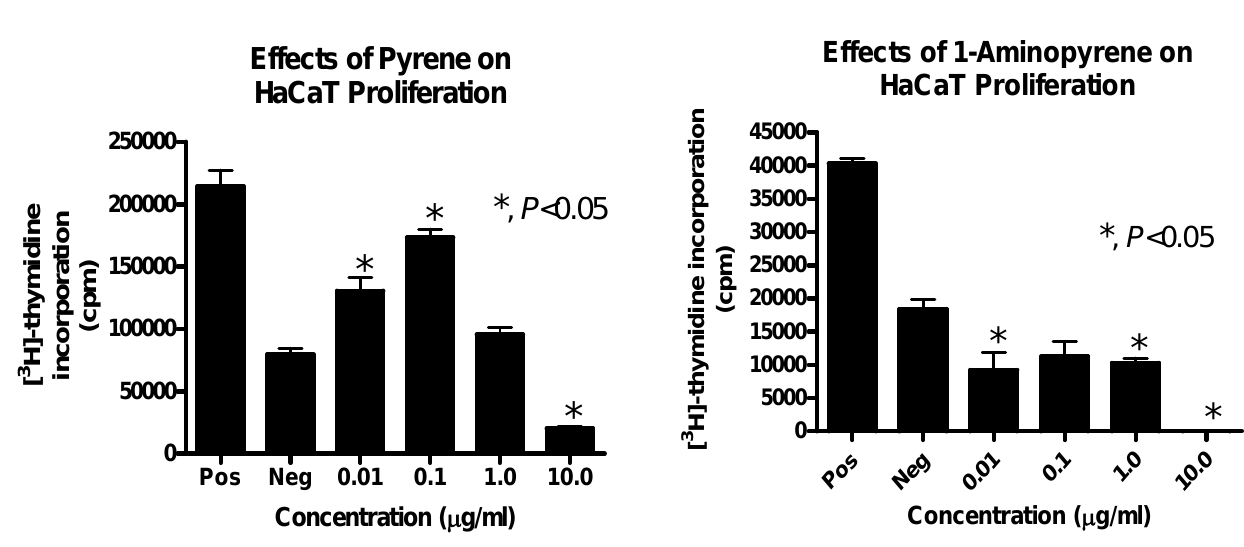
Figure 1: Effects of UV-A light on HaCaT proliferation. HaCaT cells were grown in 35mm plates to subconfluent in CGM. Cells were serum starved for 24 hours and then exposed to UV-A (3.9J/cm 2 /min) for 20, 40, 60, 80, 100, 120, 140, 160, 180, and 200 minute intervals. Thymidine incorporation assay was then performed as described in materials and methods. Results represent the mean +/- SD values of experiment performed in triplicate. [* indicates that treatment mean is significantly different from negative control according to Dunett test ( p <0.05)].